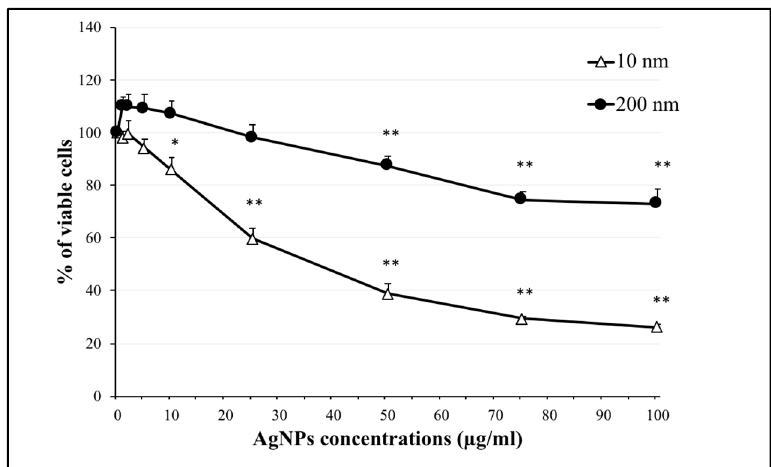
Figure 1. Effect of silver nanoparticles (AgNPs) (10 nm and 200 nm) on the viability of NCI-H292 cells. Viability of cells exposed to 10 nm and 200 nm AgNPs separately at concentrations of 0, 5, 10, 25, 50, 75, and 100 µg/mL. Cells were exposed to AgNPs for 24 h, then cell viability was determined using a CellTiter-Glo ® luminescent cell viability assay. The results are shown as means ± SD, n ≥ 3, for each group; *0.01 < P < 0.05, ** P < 0.01. * Represents significance compared to the control group.